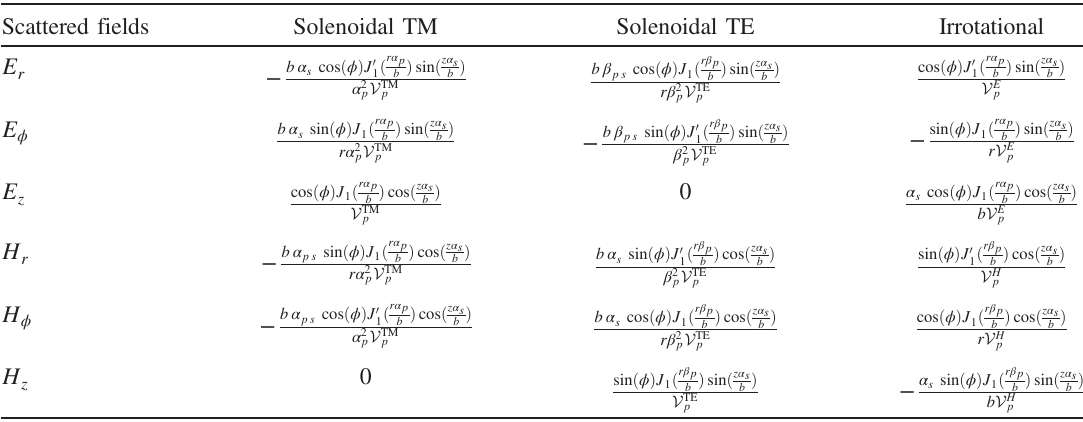
TABLE IV. Scattered field components (subdomain